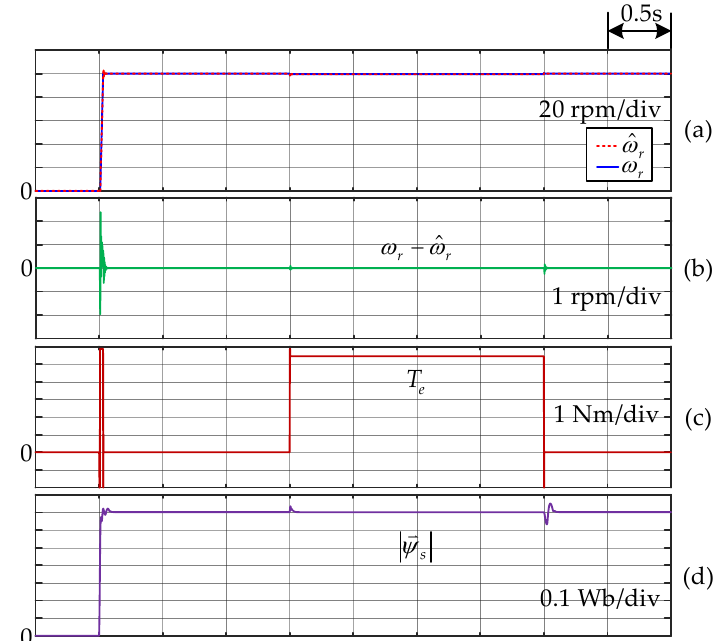
Figure 5. Simulation results when step speed from standstill to 100 rpm then 100% step-load change ( a ) actual speed response ( ω r ) and estimated speed response ( ˆ ω r ), ( b ) estimation error, ( c ) torque response, ( d ) stator flux magnitude response.